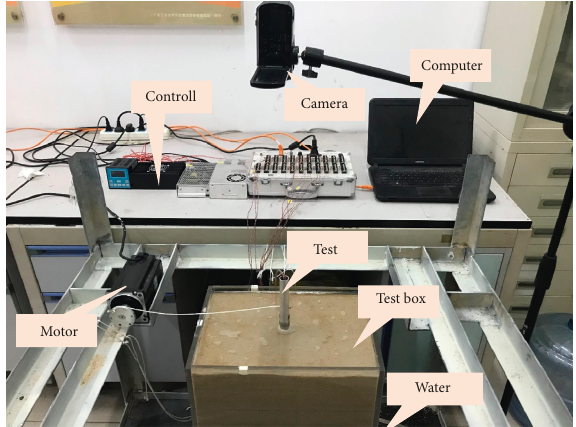
Figure 3: Test device